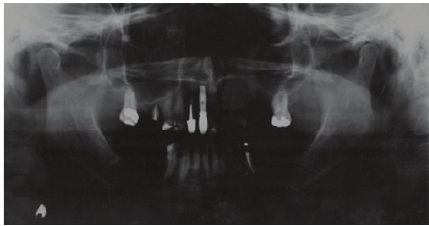
Figure 2: Initial panoramic radiography (August